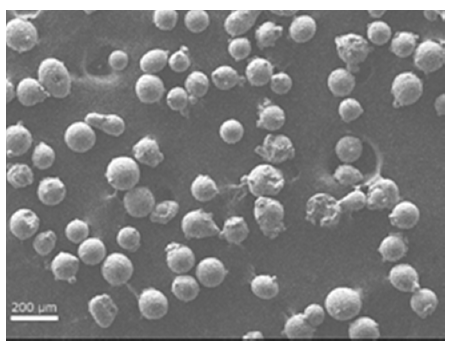
Figure 2. Scanning electron microscope image showing spherical powder particles.